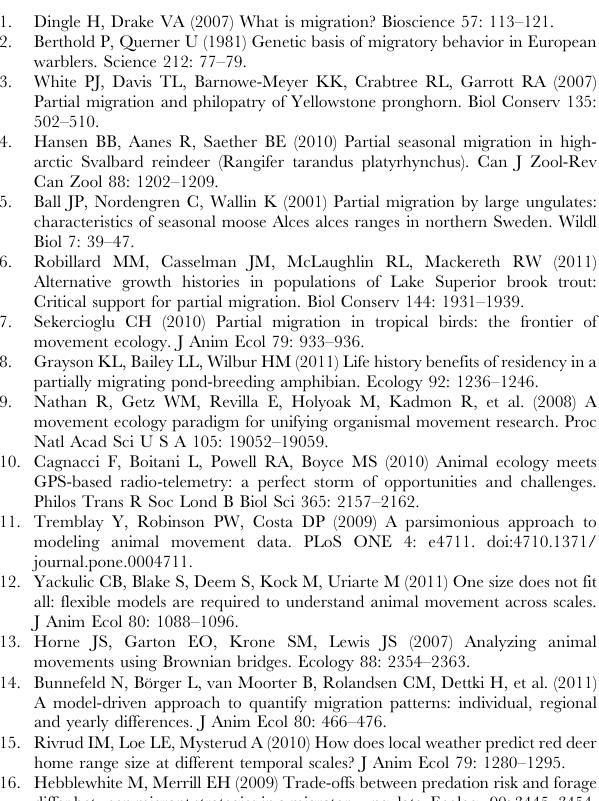
Figure S1 Results of statistical modeling when exclud- ing non-migratory individuals. Model-averaged (over the set of 4096 candidate regression models) standardized regression coefficients for variables explaining wet season migratory move- ments in African buffalo. Variable abbreviations: frac_mean